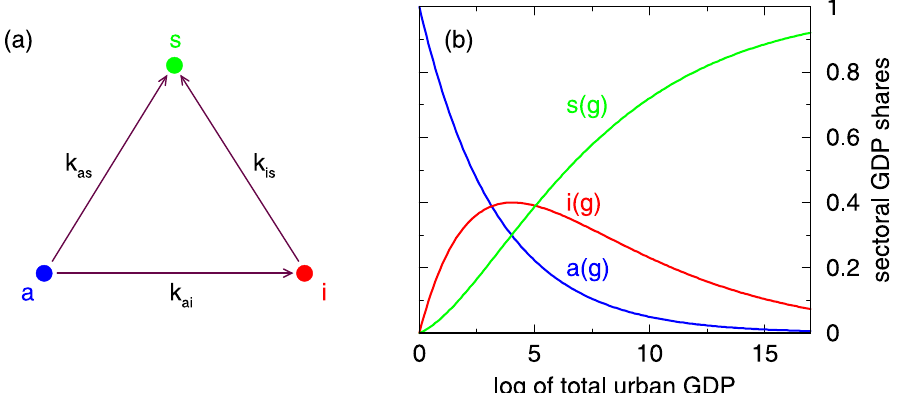
Fig 4. Illustration of the transfer dynamics among urban agriculture, urban industry, and urban service. (a) For illustrative purposes here we use a different set of parameters, namely d a ¼ k d s a þ k i , with k ai = α k 1 , k is = k 2 , and k as = (1 − α ) k 1 [7]. (b) Illustrative example of Eqs (1)–(3), i.e. for k 1 = 0.3, as is d g k 2 = 0.2, α = 0.9, and g 0 =